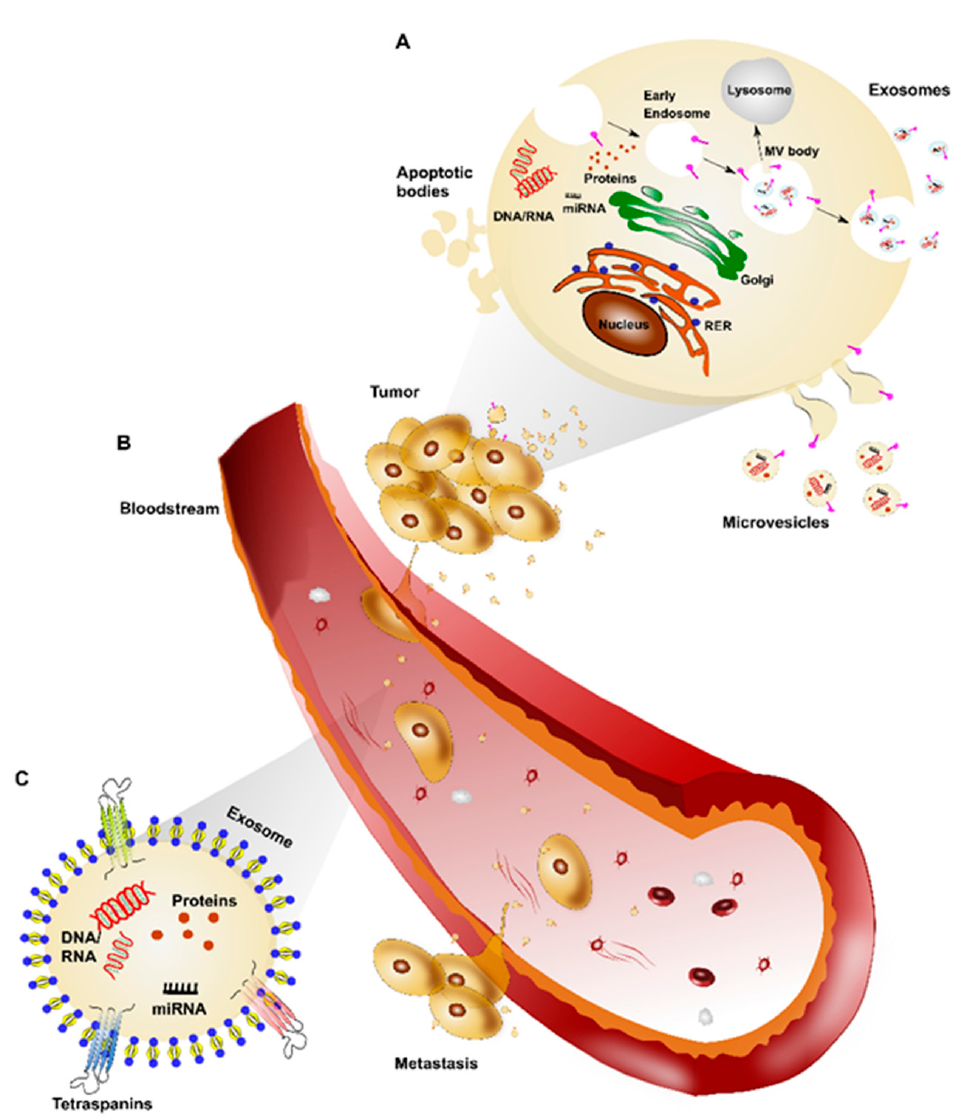
Figure 1. Extracellular vesicle (EV) biogenesis and role in tumor. ( A ). Tumor cells can release EVs involved in cell-to-cell communication; these are classified as exosomes, microvesicles and apoptotic bodies based on their origin and size. ( B ) Exosomes released by tumor cells reach the bloodstream and play an important role in metastasis development. ( C ) Exosomes are small lipid bilayer-enclosed vesicles, characterized by the presence of transmembrane tetraspanin proteins and a content of RNA, DNA, miRNA as well as proteins.